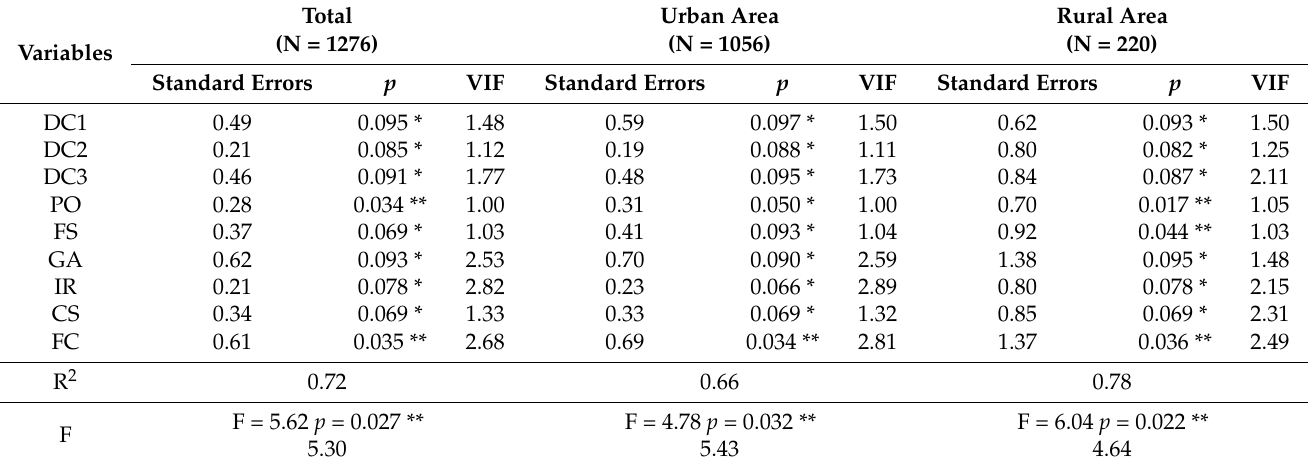
Table 7. OLS regression results on the quality of life for older